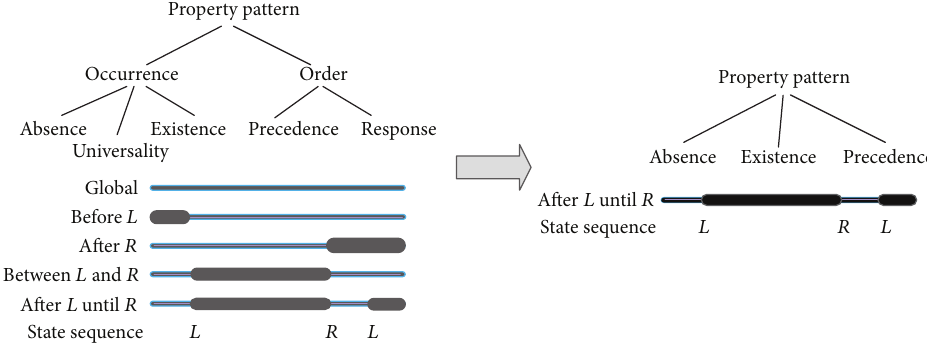
Figure 4: The simplification of